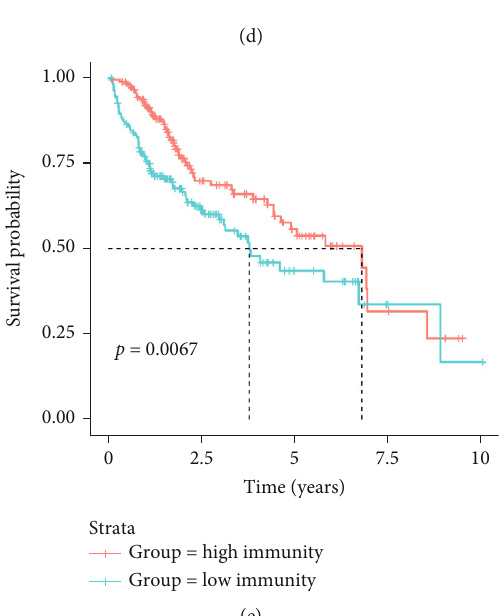
Figure 1: Consensus clustering and survival analysis of HCC based on hepatocyte immune-related gene sets. (a) CDF curves with di ff erent K values. (b) CDF delta area plot, which represents relative change in the area under the CDF curve for k compared to k − 1 , with abscissa indicating k and ordinate indicating relative change in the area under the CDF curve. (c) 374 HCC patients were divided into 2 molecular subtypes. (d) Heatmap of 29 immune gene expression levels in samples with 2 molecular subtypes. (e) Kaplan-Meier survival curves between high- and low-immune